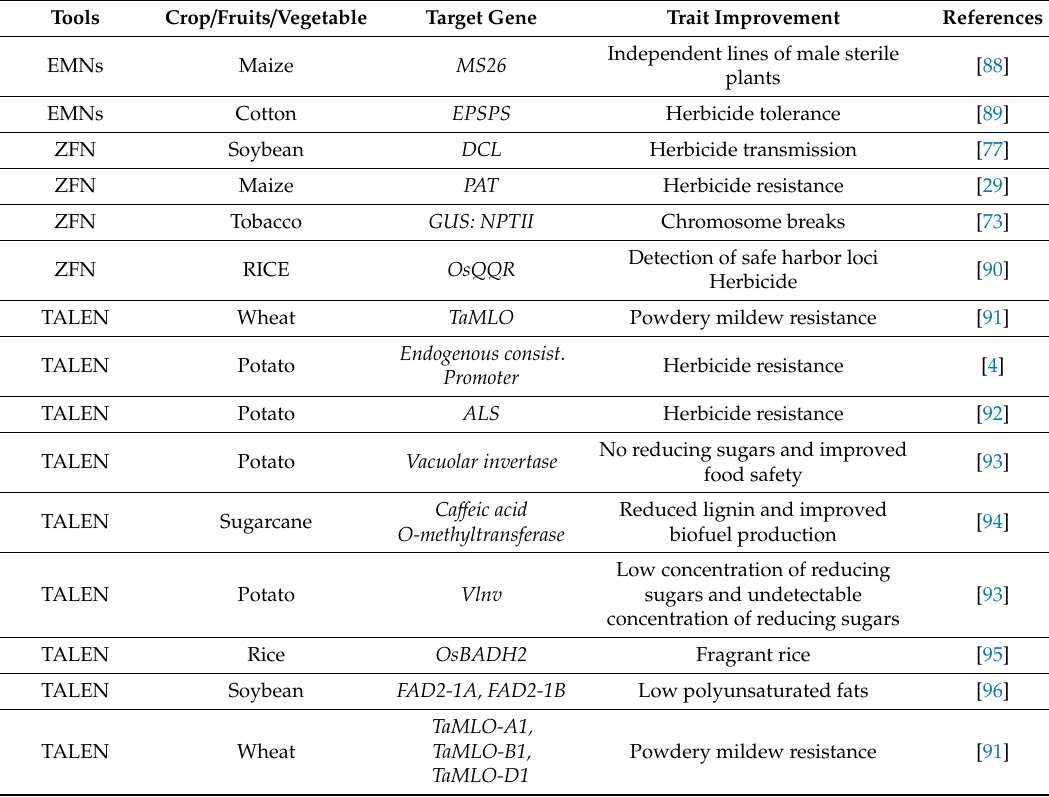
Table 2. Improvement in crops, fruits, and vegetables via EMNs, ZFNs, and TALENs.